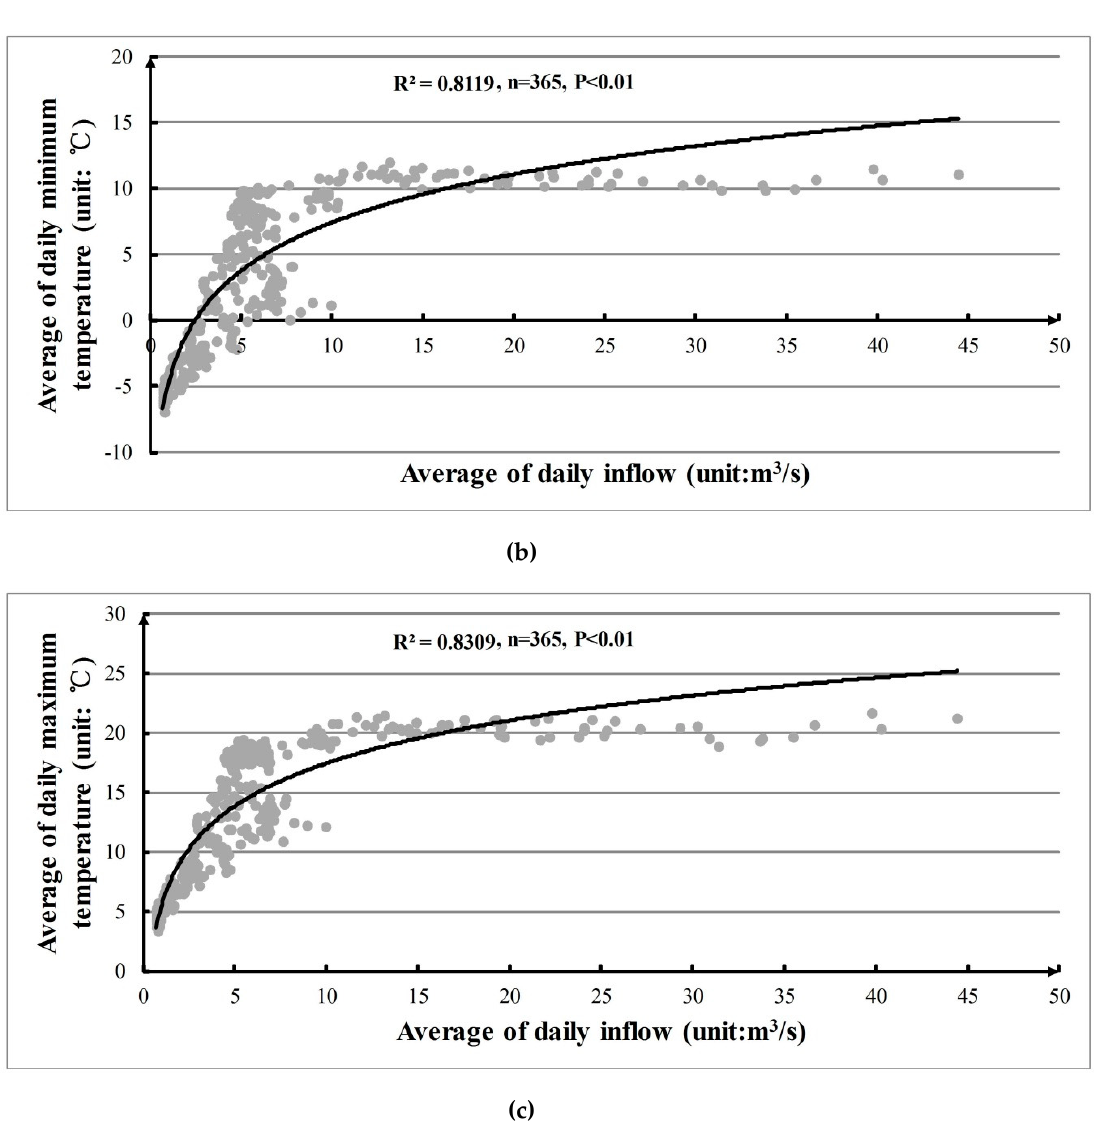
Figure 4. Dependence of the average of daily inflow on average of daily precipitation, minimum temperature, and maximum temperature. ( a ) Relationship between average of daily inflow and precipitation; ( b ) Relationship between average of daily inflow and minimum temperature; ( c ) Relationship between average of daily inflow and maximum temperature..